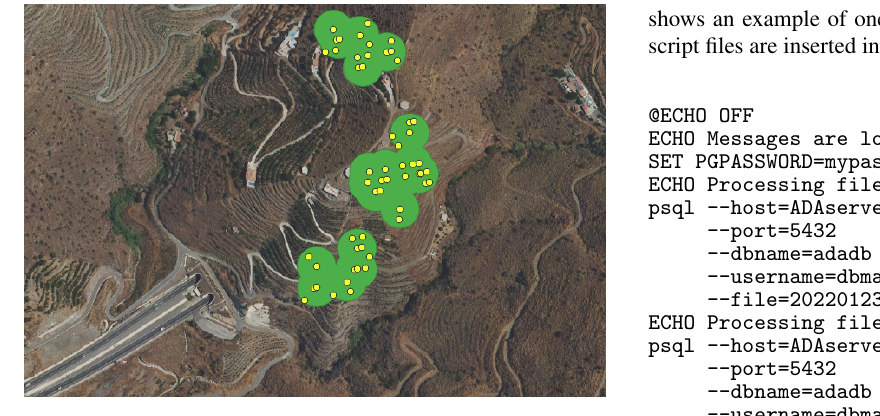
Figure 4. Some reliable ADA and the PS inside them.